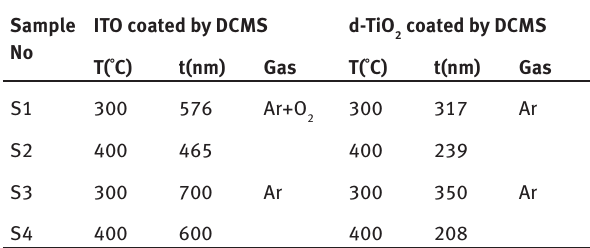
films coated by DCMS 2